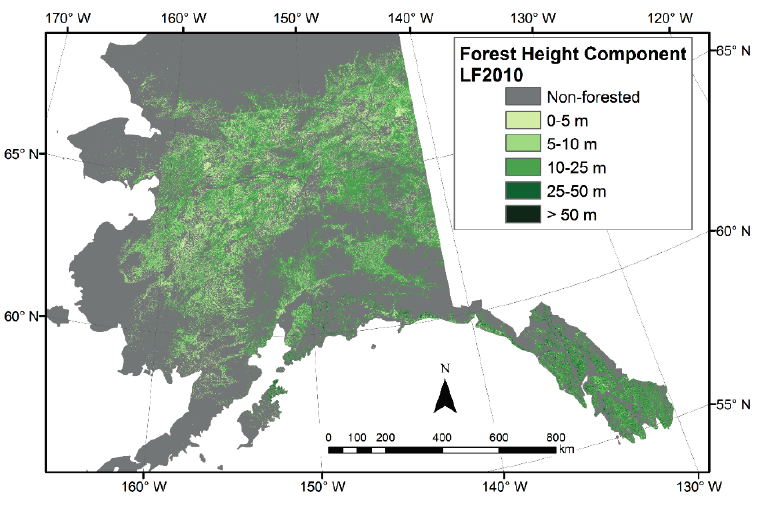
Figure 5. Updated map of LANDFIRE National forest height component for Alaska mapped as five classes.